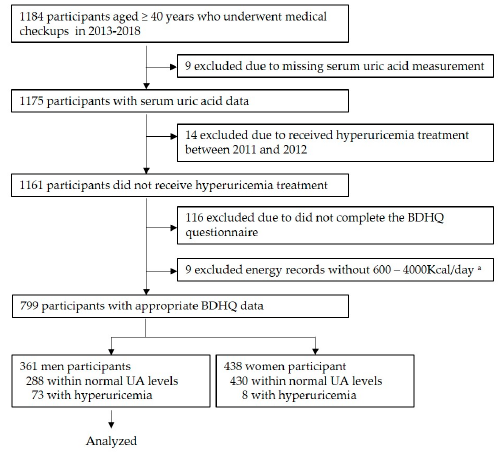
Figure 1. Participant recruitment chart. a This reference value was chosen for the following reasons: less than 600 kcal/day is equivalent to half the energy intake required for the lowest physical activity category; more than 4000 kcal/day is equivalent to 1.5 times the energy intake required for the me- dium physical activity category. Abbreviations: BDHQ, brief-type self-administered diet history questionnaire.